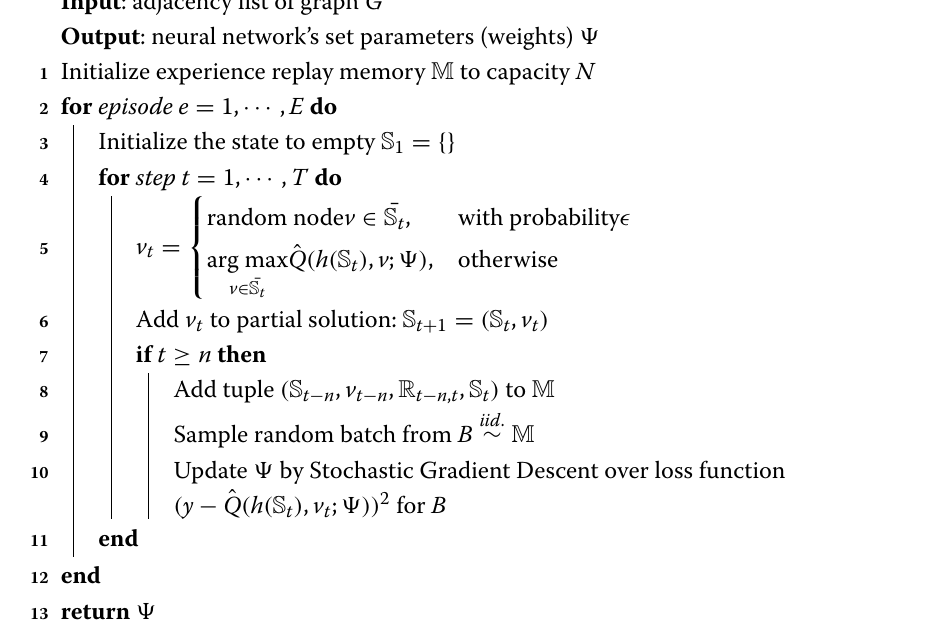
Algorithm 1: n-step Fitted Q-Learning for Approximating the Minimum Vertex Cover